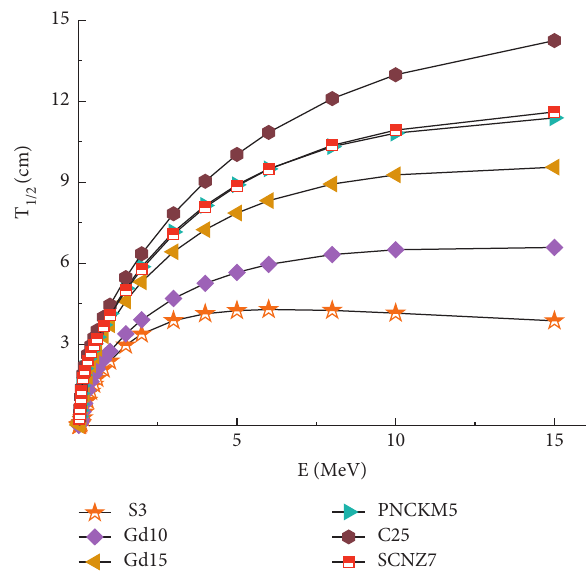
Figure 16: Comparison of the HVL values with different types of glasses.